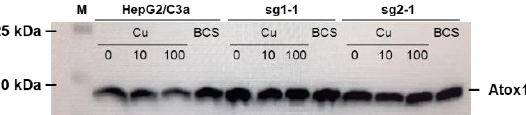
Figure 2. Expression of Atox1 in the different cell lines and depending on Cu conditions. Western blot analysis of the expression of Atox1 in the HepG2/C3a cell line and in different clones isolated after the CrispR/Cas9 process. Cells have been exposed to nothing, 10 µM Cu, 100 µM Cu, or 200 µM BCS for 24 h.